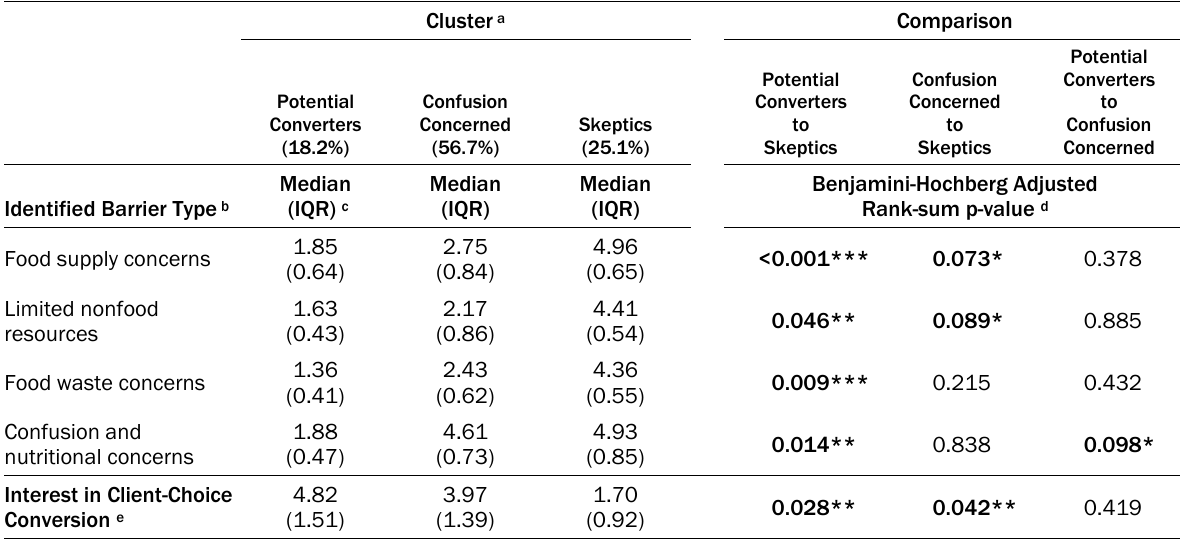
Table 2. Comparison Statistics for Median Identified Barrier Type Values and Interest in Client-Choice Conversion, by Cluster ( n